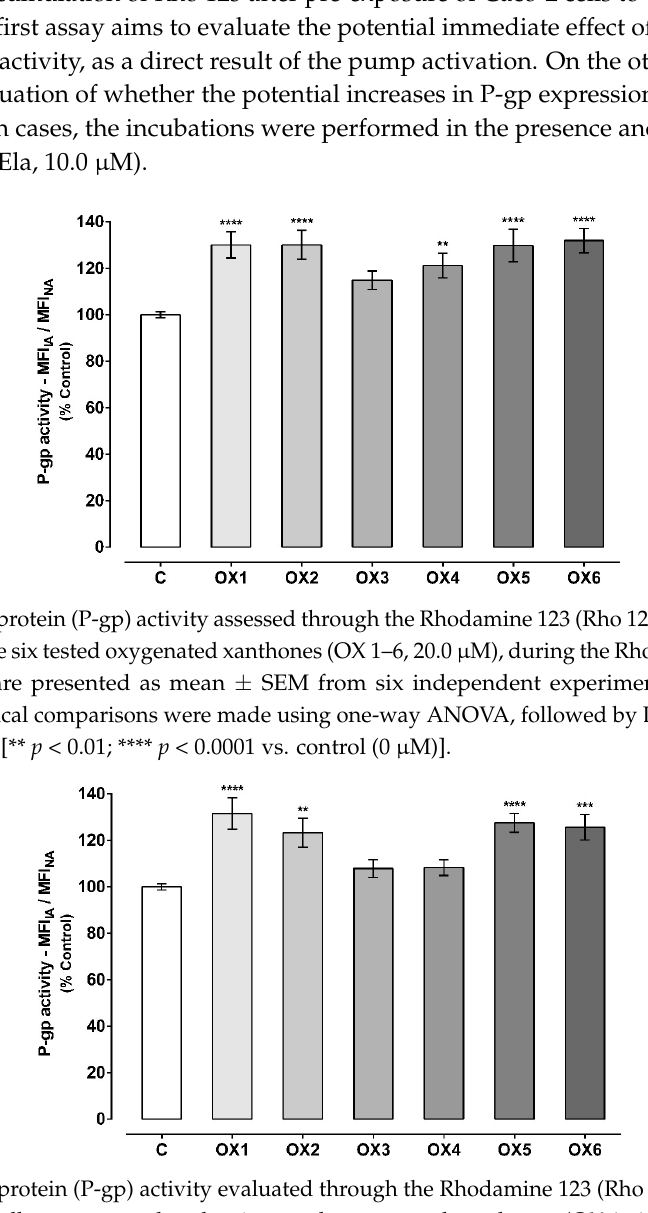
Figure 5. P-glycoprotein (P-gp) activity evaluated through the Rhodamine 123 (Rho 123) accumulation assay in Caco-2 cells pre-exposed to the six tested oxygenated xanthones (OX 1–6, 20.0 µ M) for 24 h. Results are presented as mean ± SEM from six independent experiments (performed in duplicate). Statistical comparisons were estimated using one-way ANOVA, followed by Dunnett’s multiple comparisons test [** p < 0.01; *** p < 0.001; **** p < 0.0001 vs. control (0 μ M)].